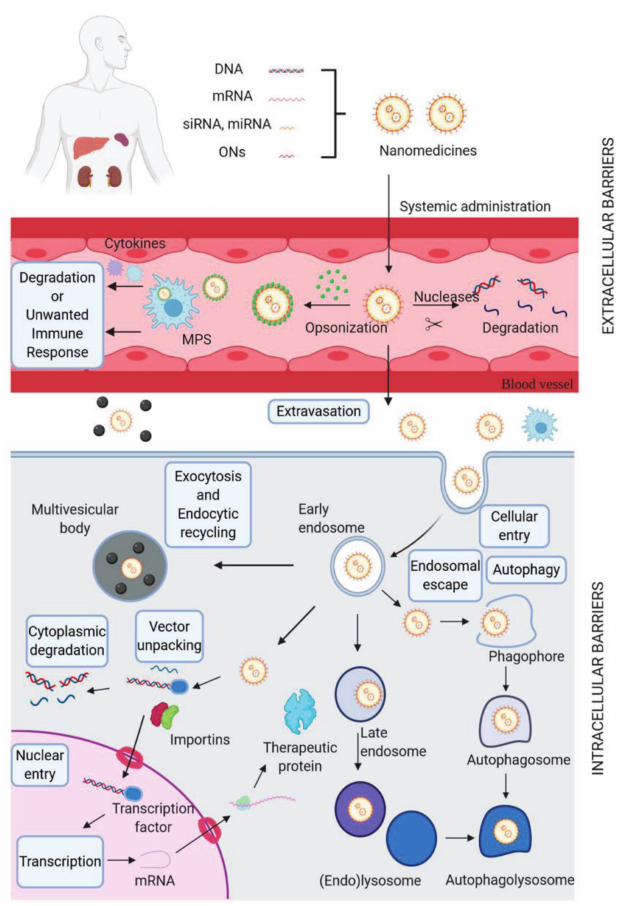
Figure 7. Mechanism of action of PNPs as gene delivery systems for cancer treatment. Reprinted with permission from Ref. [108]. Copyright 2021